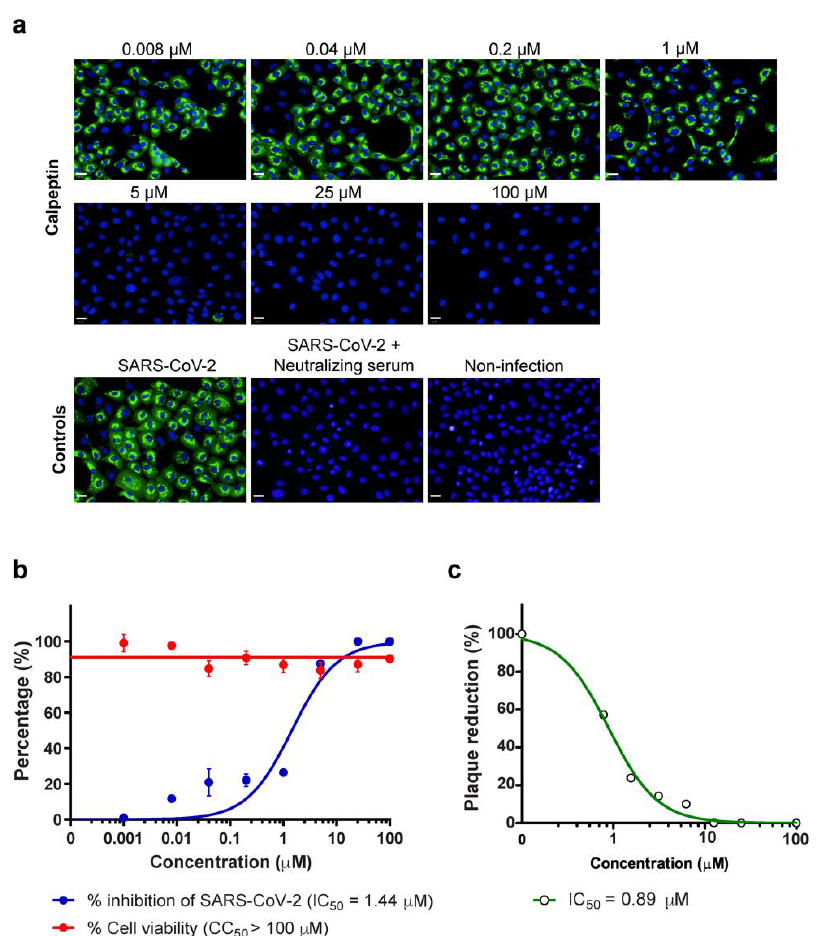
Figure 3. The dose-dependent effect, the half maximal inhibitory concentration (IC50), and the half maximal cytotoxicity (CC50) of calpeptin against SARS-CoV-2 infected Vero E6 cells. Vero E6 cells were infected with SARS-CoV-2 at 25TCID50 for 2 h and then post-infection treated with calpeptin, at concentrations ranging from 0.008 to 100 µ M, for 48 h. Positive convalescent serum of a COVID-19 patient was included as a positive control. The supernatant was collected for viral output quantification. The infected cells were fixed and stained for viral nucleoproteins with anti-SARS-CoV NP mAb. The SARS-CoV-2 infected cells were detected by high-content imaging. ( a ) The high-content images of calpeptin treatment in SARS-CoV-2 infected Vero E6 cells are demonstrated. Scale bar: 20 µ m. The percentage of inhibition was calculated as the percentage of the control conditions. The cytotoxicity assay was performed in parallel to evaluate the cell viability at each concentration. ( b ) The percentage of virus inhibition (blue) and cell viability (red) is shown. The data are presented as mean ± SEM of three biological replicates. ( c ) Viral output was examined by plaque reduction assay, and data are presented as % of the control ( n = 2 biological